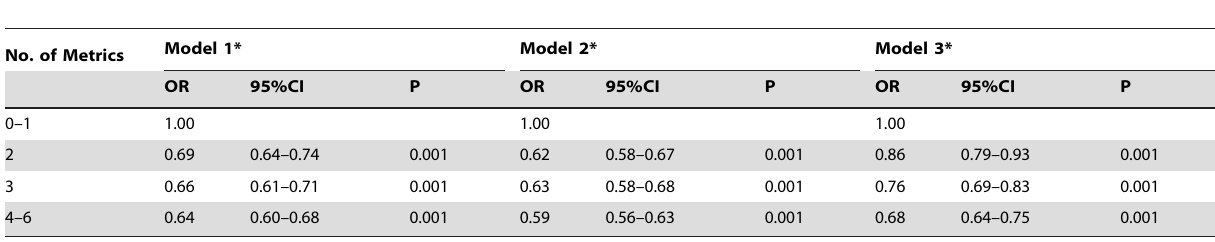
Table 2. Impact of Ideal Cardiovascular Health Behaviors and Health Factors on hsCPR